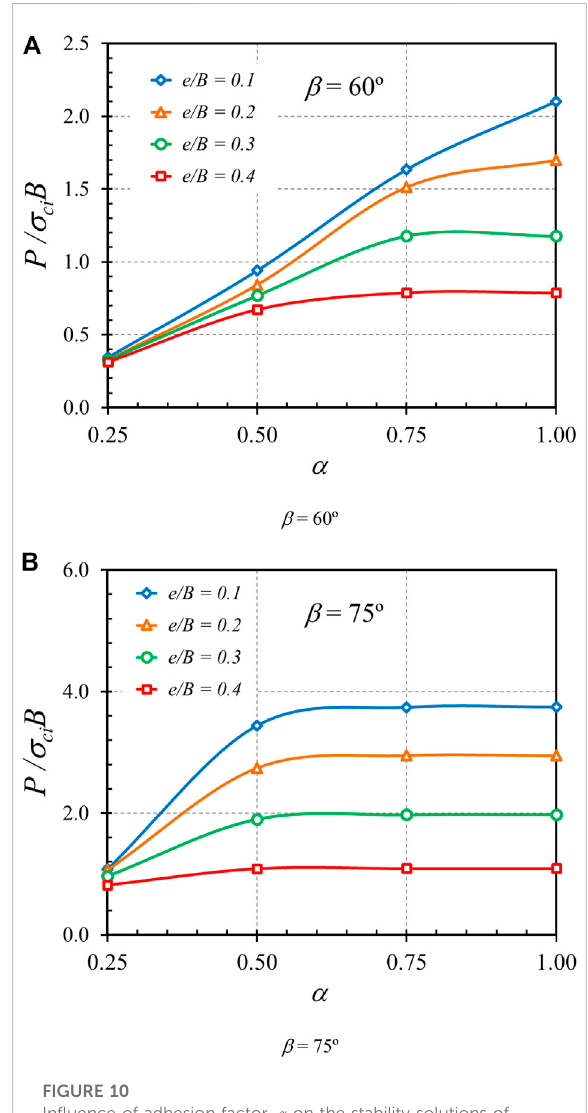
FIGURE 10 In fl uence of adhesion factor, α on the stability solutions of bearingcapacityfactorontherockmass( GSI =100, γ B/ σ ci =0,and m i = 5). (A) β = 60 ° (B) β = 75 °